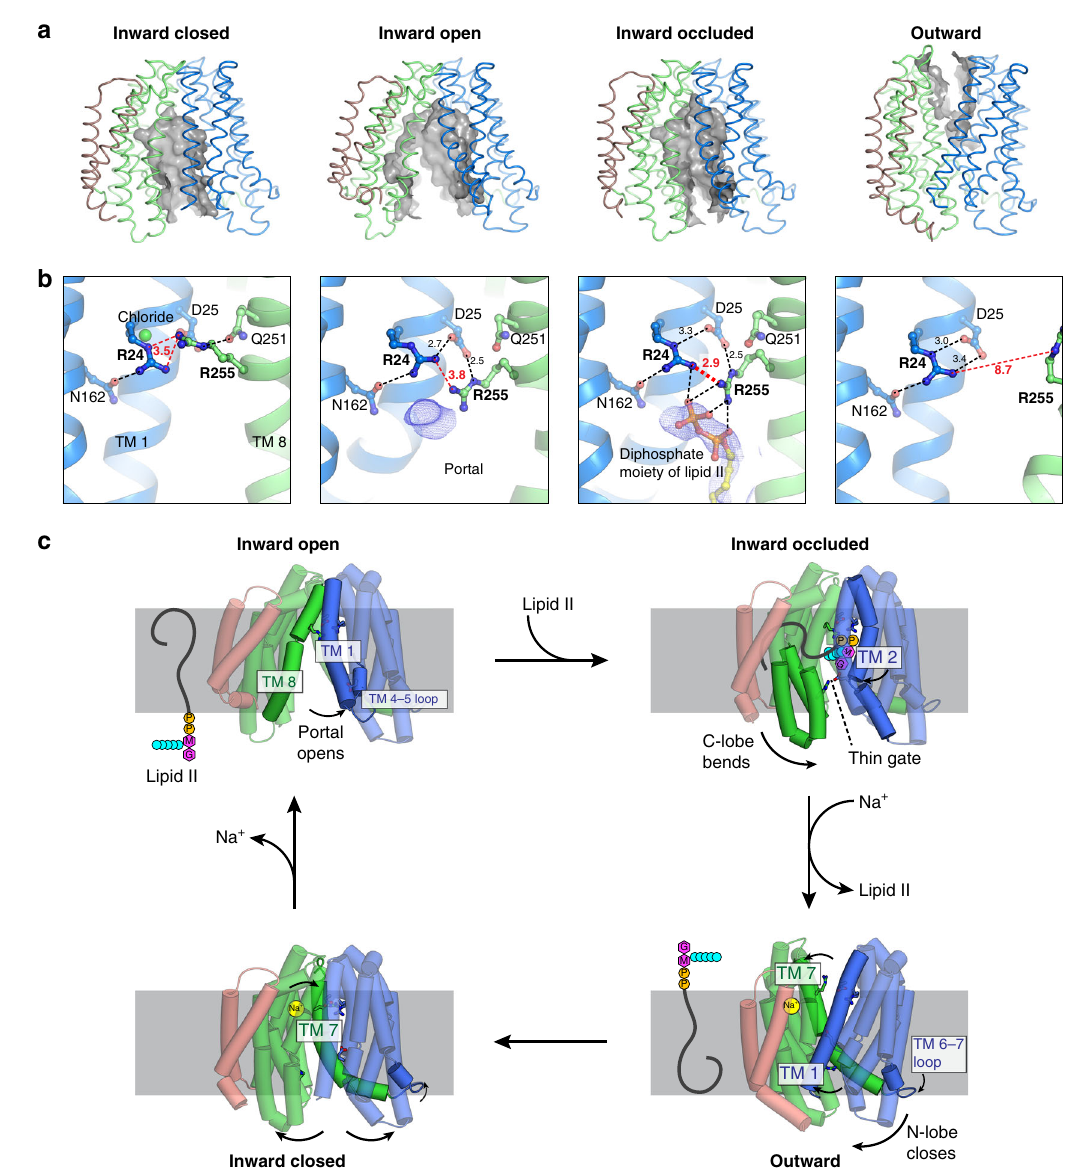
Fig. 6 State-dependent conformational changes in the central cavity during the transport cycle. a The inward-facing cavity opens up in the inward-open conformation, and then extends deepest into the membrane in the inward-occluded conformation. In contrast, the outward-facing cavity is narrow and shallow. b Systematic rearrangement of the Arg24-Asp25-Arg255 triad in the cavity during the transport cycle. In the inward-occluded state, Arg24 and Arg255 are brought into unusual proximity (just 2.9 Å apart at the closest), with the unfavorable repulsion stabilized by electrostatic interactions with Asp25 and the diphosphate moiety of Lipid II. The lipid-diphosphate model was docked into fi nal electron density (blue mesh, contoured to 1.0 σ ) and was never used for re fi nement or map calculation. c Proposed model of the MurJ transport